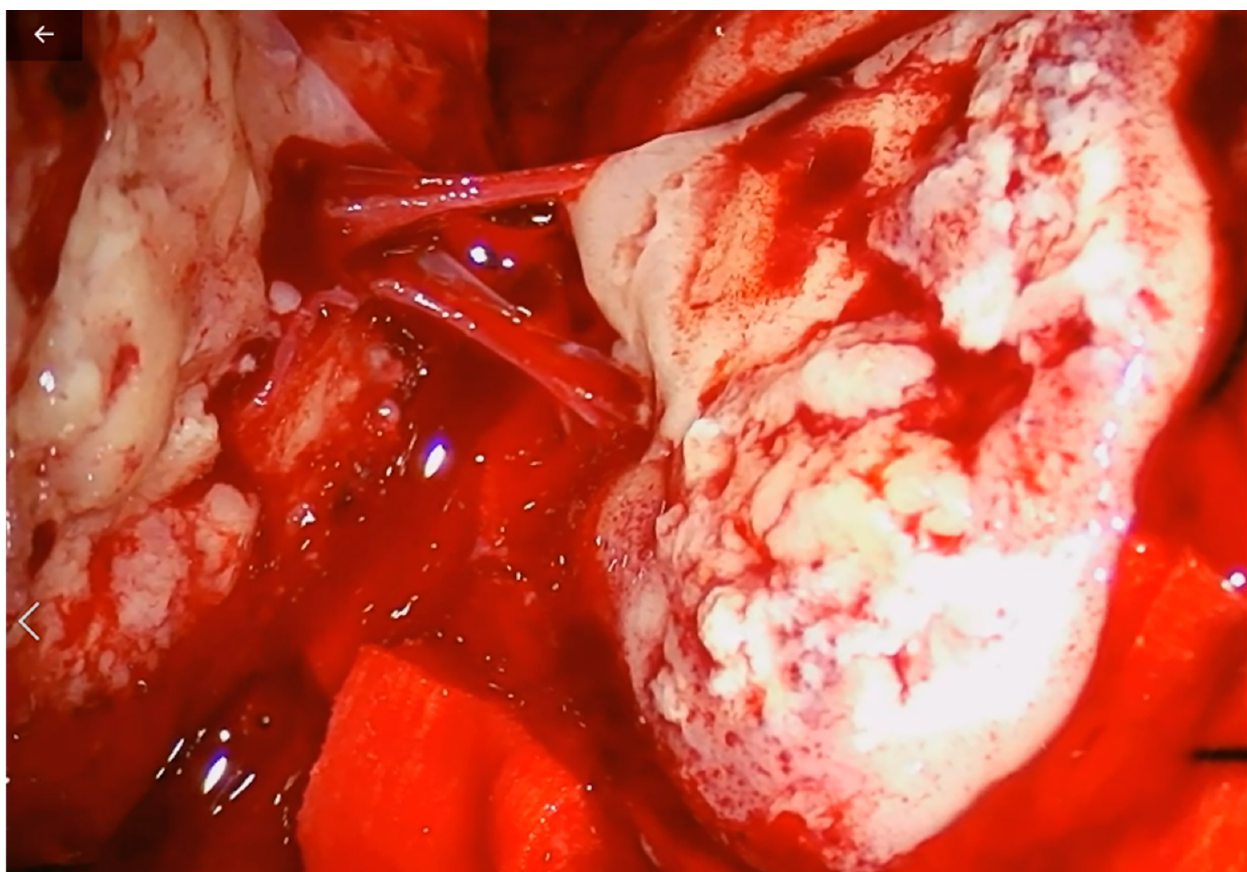
Figure 2. Cortical vein involved in focal thrombosis due to surgical manipulation.